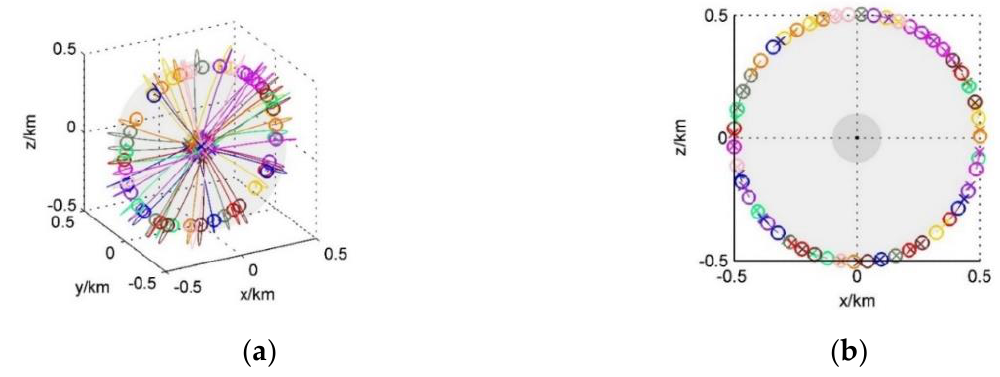
Figure 15. The in-plane circle formation ( r = 0.5 km, µ = − 20 km). ( a ) Relative motion trajectory in 0-500 s; ( b ) Relative motion trajectory in 500–2000 s.